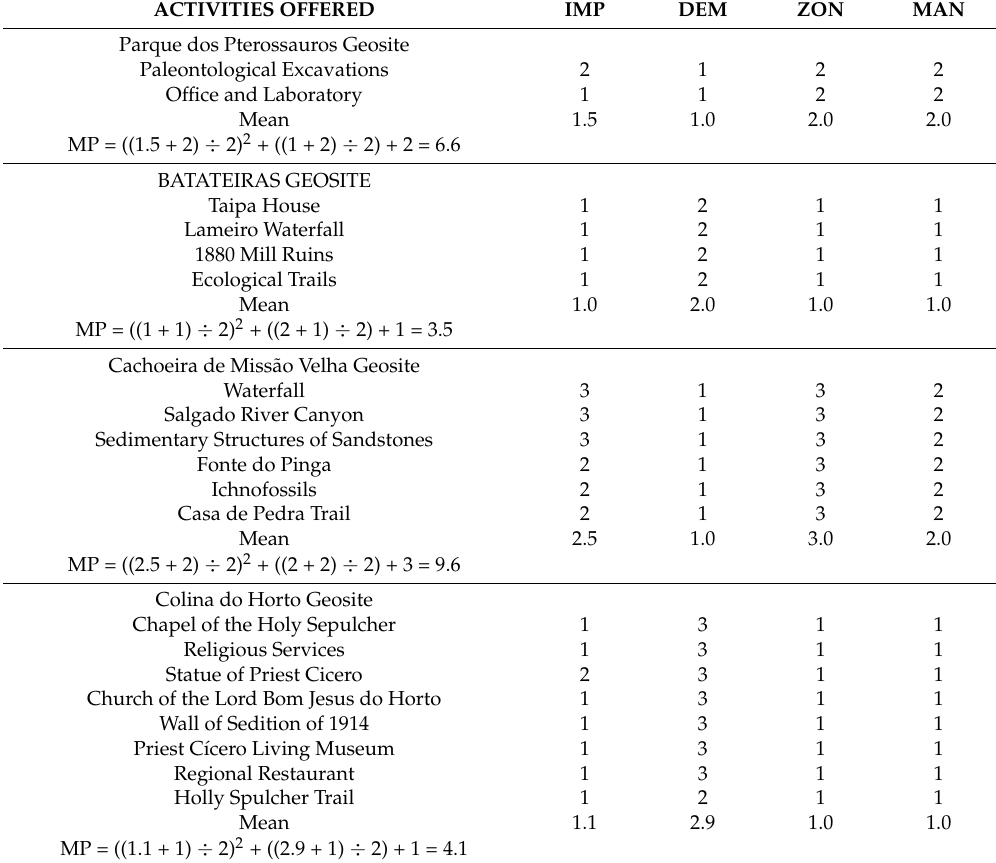
Table 6. Correlation of the variables in the visitation activity of